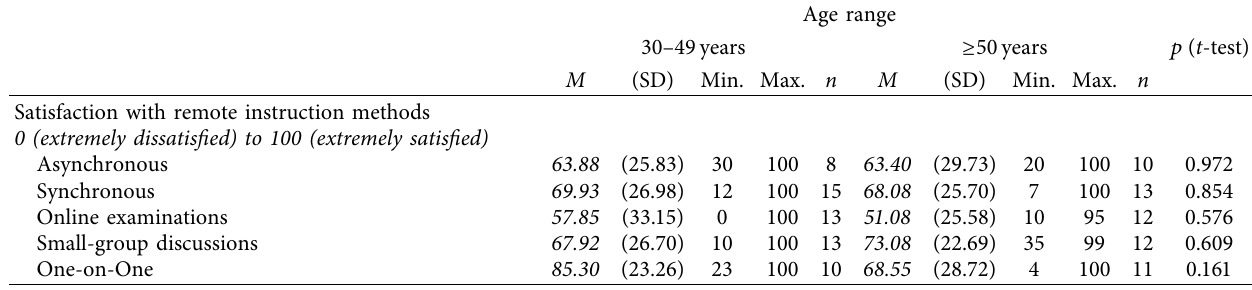
Table 3: Self-reported satisfaction with instruction methods used during remote instruction and the impact of various factors on the experience of faculties during this